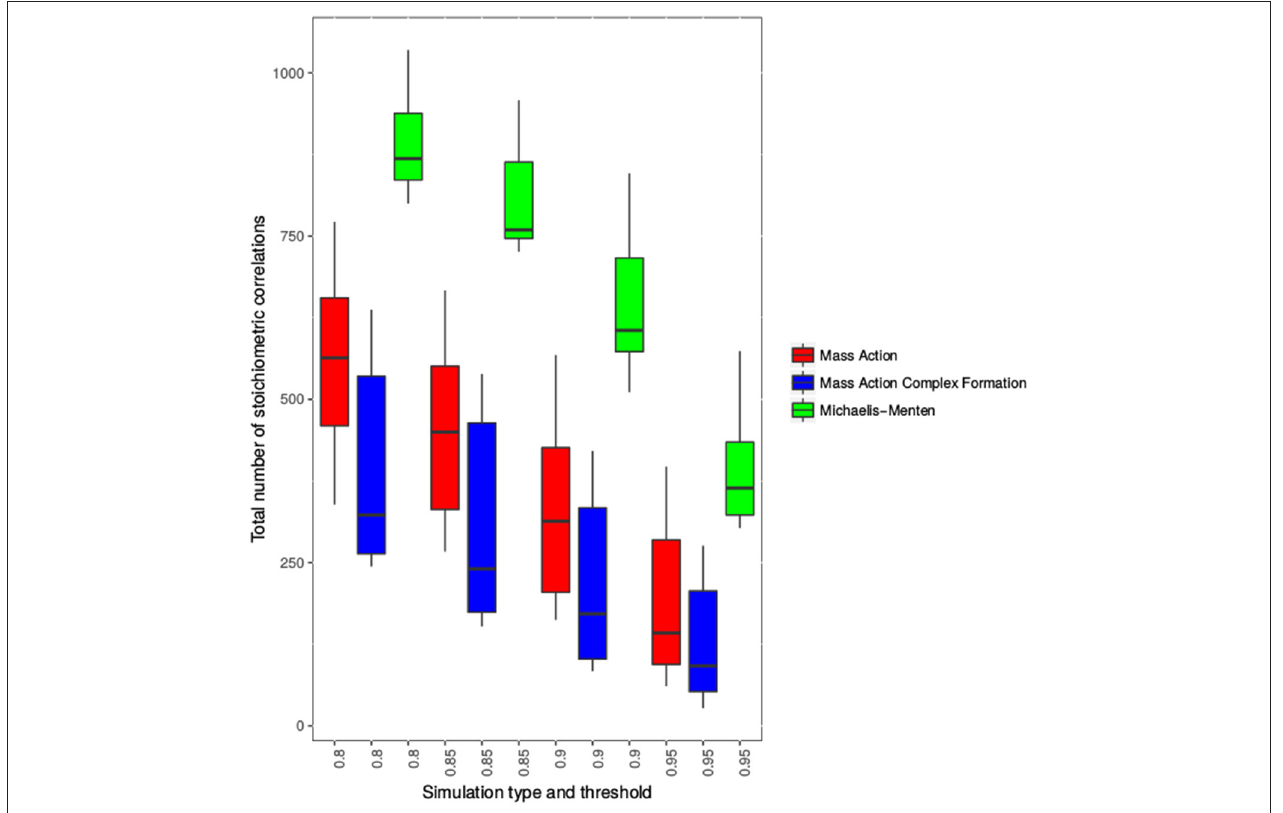
FIGURE 3 | Distribution of the number of stoichiometric correlations for three models of the TCA cycle. Shown are the distributions of the total number of stoichiometric correlations at four thresholds 0.8, 0.85, 0.9, and 0.95. The distributions for the mass action simulation are shown in red, the distributions for the substrate-enzyme complex mass action simulation are shown in blue, whereas the Michaelis-Menten simulation of the TCA cycle is shown in green.